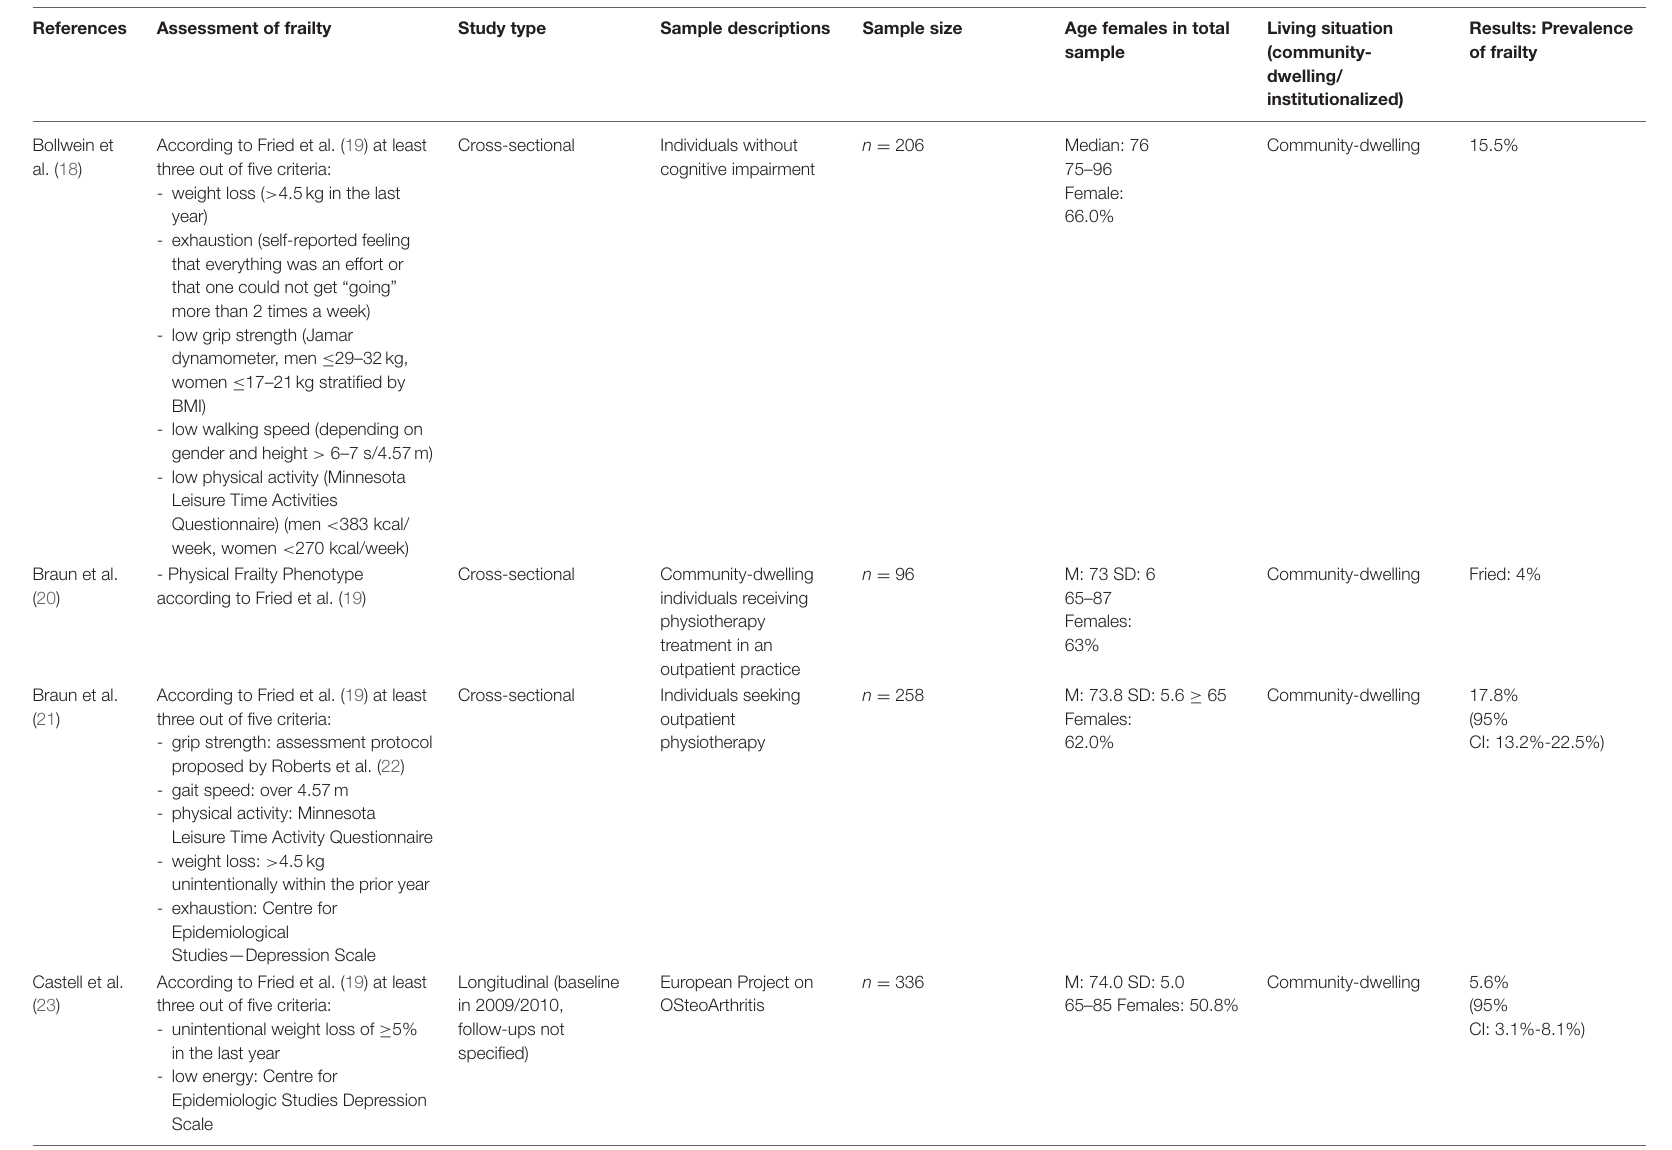
TABLE 2 | Study overview and key